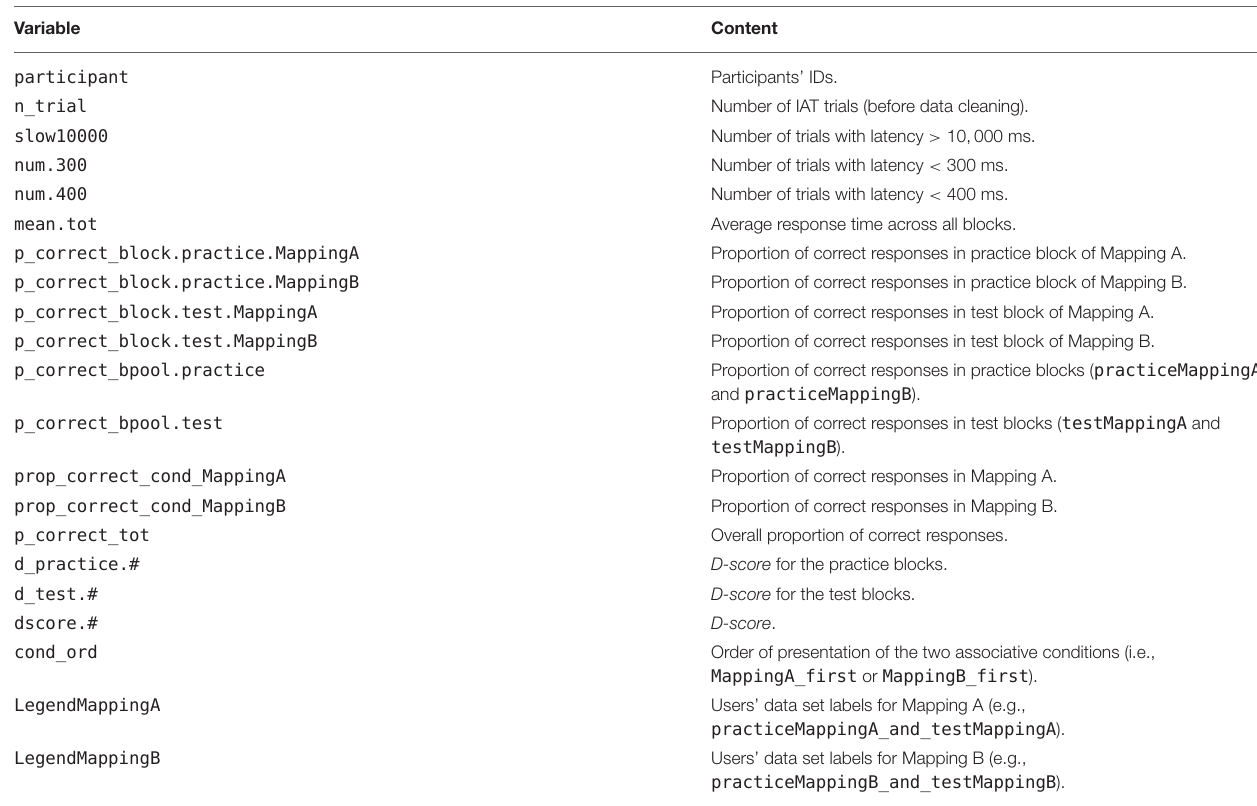
TABLE 4 | Content of the Downloadable File. Variable Content